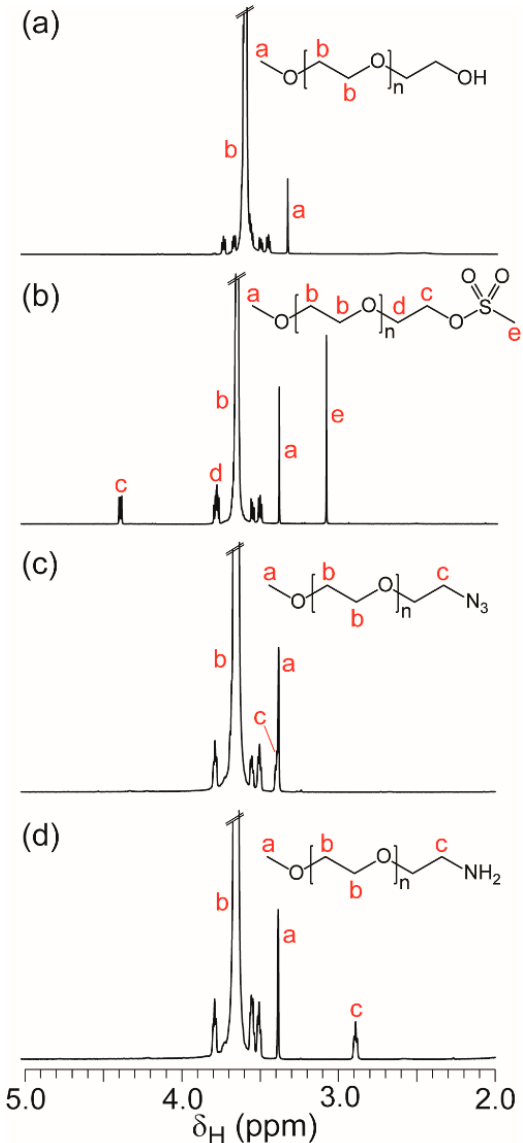
Figure 1. 1 H NMR spectra (500 MHz, 23 °C, CDCl 3 ) showing the conversion of the ( a ) α -methoxy- ω -hydroxy PEG 5k to its ( b ) α -methoxy- ω -mesylate, ( c ) α -methoxy- ω -azido and ( d ) α -methoxy- ω -amino derivatives.